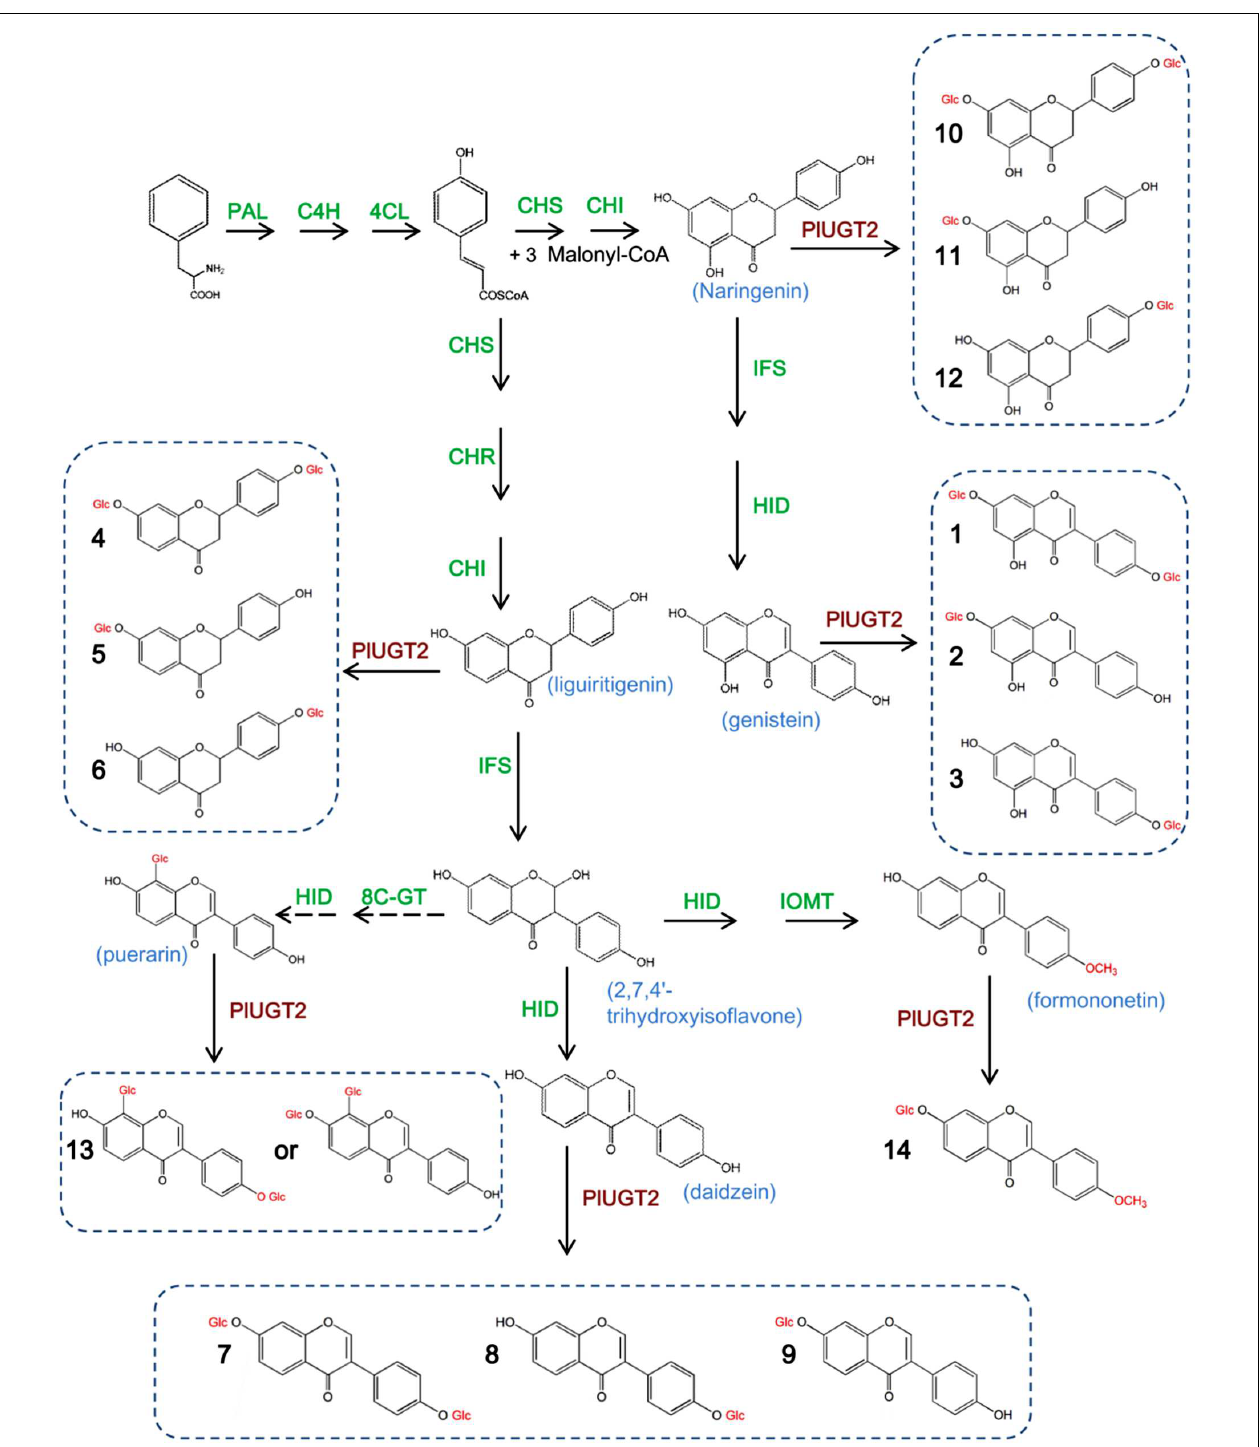
FIGURE 1 | Proposed pathways for isoflavone glucosylations catalyzed by PlUGT2 in Pueraria lobata . PAL, phenylalanine ammonia-lyase; C4H, cinnamate 4-hydroxylase; 4CL, 4-coumarate:CoA ligase; CHS, chalcone synthase; CHI, chalcone isomerase; CHR, chalcone reductase; IFS, isoflavone synthase; HID, 2-hydroxyisoflavanone dehydratase; PlUGT2, P. lobata UDP-glucosyltransferase 2; IOMT, isoflavone O- methyltranferases. The dotted arrow indicates that the enzymes involved were not yet clear. (1) genistein 4 (cid:48) ,7- O- diglucoside; (2) genistin (genistein 7- O- glucoside); (3) sophoricoside (genistein 4 (cid:48) - O- glucoside); (4) liquiritigenin 4 (cid:48) ,7- O- diglucoside; (5) neoliquiritin (liquiritigenin 7- O- glucoside); (6) liquiritin (liquiritigenin 4 (cid:48) - O- glucoside); (7) daidzein 4 (cid:48) ,7- O- diglucoside; (8) daidzin (daidzein 7- O- glucoside); (9) daidzein 4 (cid:48) - O- glucoside; (10) naringenin 4 (cid:48) ,7 -O- diglucoside; (11) naringenin 7 -O- glucoside; (12) naringenin 4 (cid:48) -O- glucoside; (13) purearin mono - glucoside; (14) ononin (formononetin 7- O -glucoside).